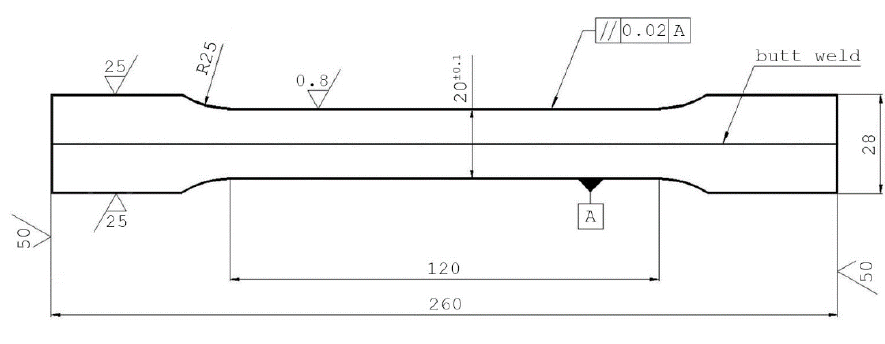
Figure 3. Laser-welded sample (length in mm, roughness in µm).